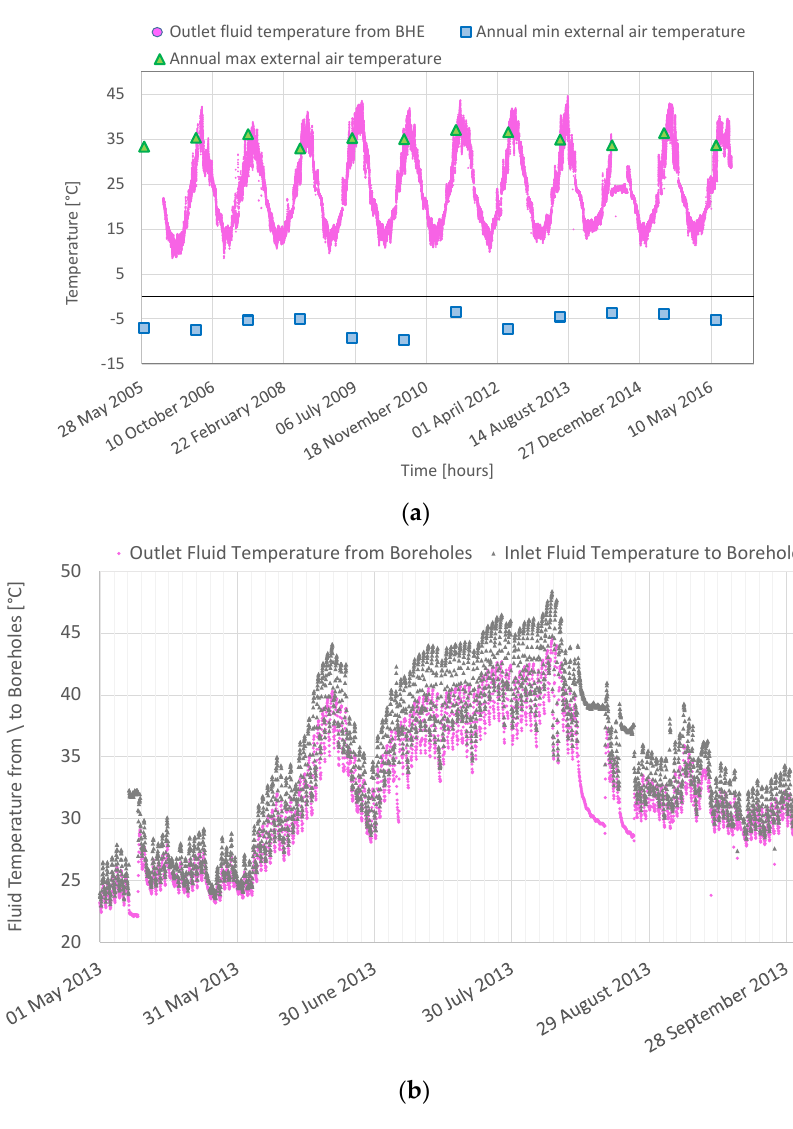
Figure 3. Measured hourly fluid temperature: ( a ) outlet fluid temperature from borehole heat exchangers with annual minimum and maximum external air temperatures, ( b ) inlet and outlet fluid temperature to/from borehole heat exchangers from May to September 2013.